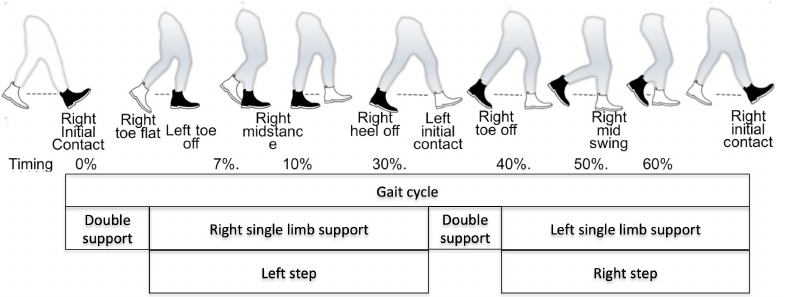
Figure 2. Gait cycle with corresponding events (along with a typical ratio-timing based on occurrence within a gait cycle) and corresponding phases; black shoe represents right foot (own depiction based on [52]). Table 1. Considered gait parameters and corresponding algorithms; based on [50,52]. Gait Parameter Description Algorithm Separately Per